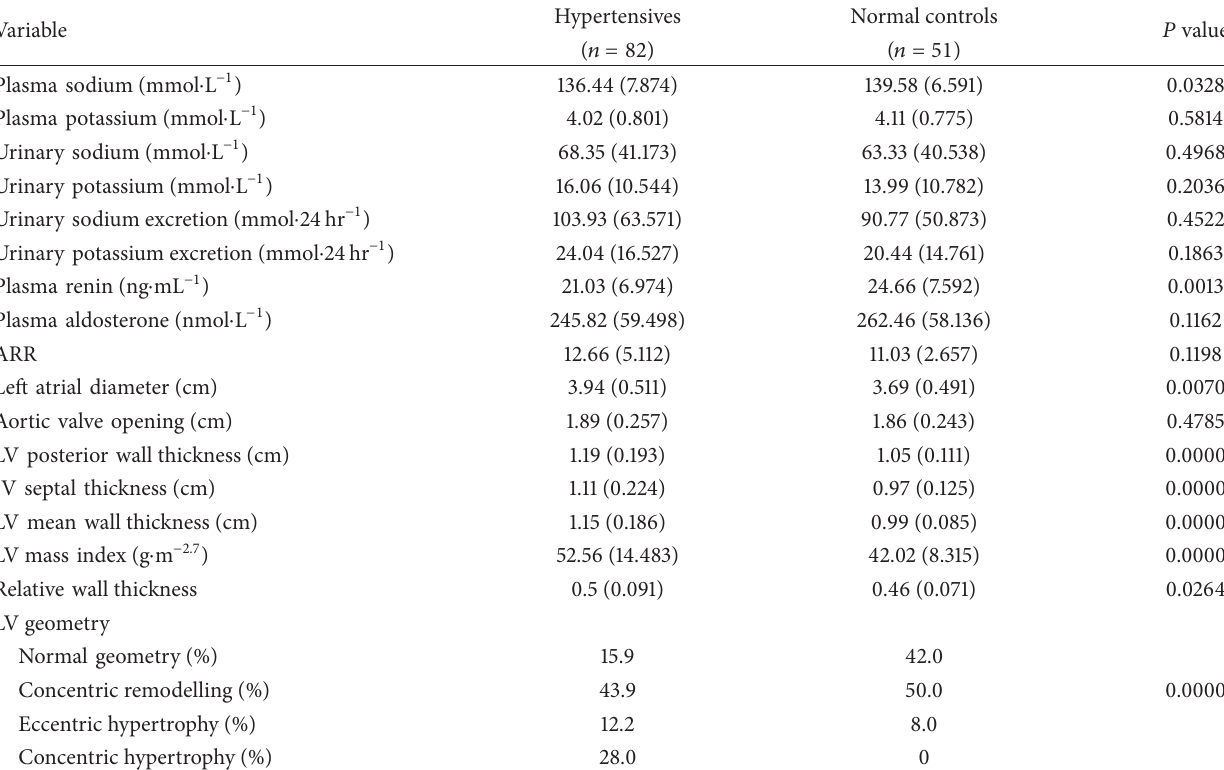
Table 2: Biochemical, hormonal, and echocardiographic characteristics of the